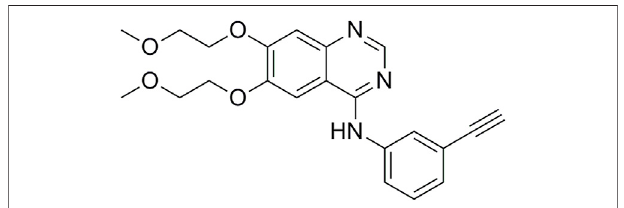
FIGURE 1 | Structure of erlotinib.